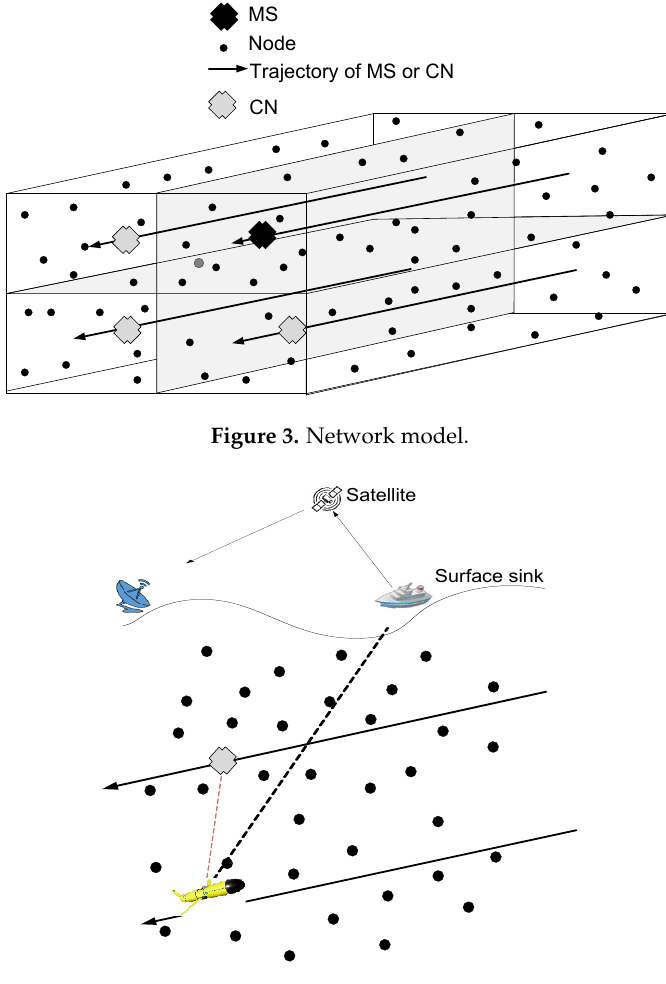
Figure 4. Courier node (CN) to mobile sink (MS)